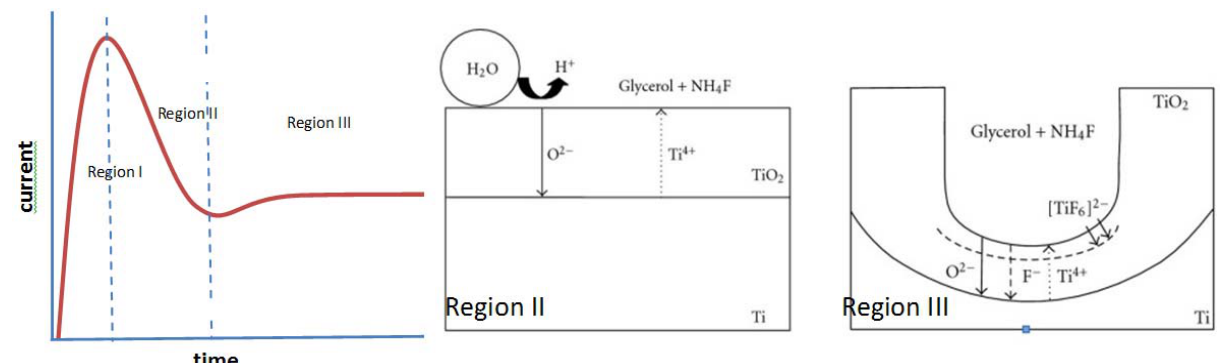
Figure 4. The current profile and nanotube formation scheme are shown. The current increases sharply in Region I as voltage is applied across the electrolyte and bare titanium foil. A compact titanium dioxide layer forms in Region II. In Region III, oxide formation and dissolution reach a steady state and nanotubes form (Equations (1)–(3)). Illustrations reprinted from [31]. Creative Commons